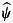
Map of snow leopard site use probability as measured by sign surveys conducted in Qilianshan National Nature Reserve, Gansu Province, China, January to March 2014.A. Naïve estimate of site use (ψ) from presence vs absence approach and B. Average estimated probabilities of site use (ψ^) per grid cell.